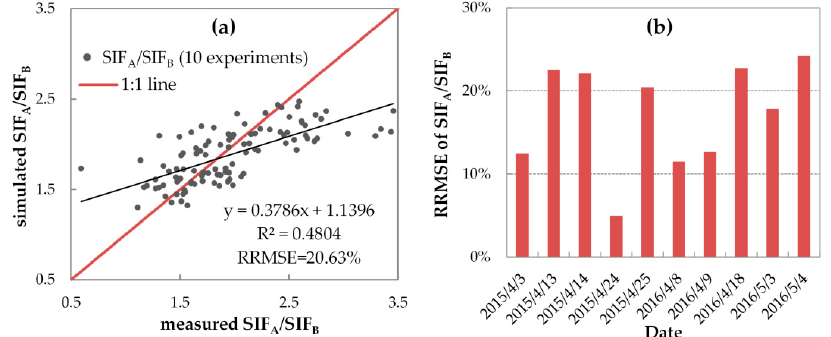
Figure 13. The correlation and relative root mean square error (RRMSE) values between simulated and measured SIF A /SIF B with variable FQE: ( a ) the correlation and RRMSE for 106 spectral measurements and ( b ) the RRMSE values for each fieldwork day in 2015 and 2016.